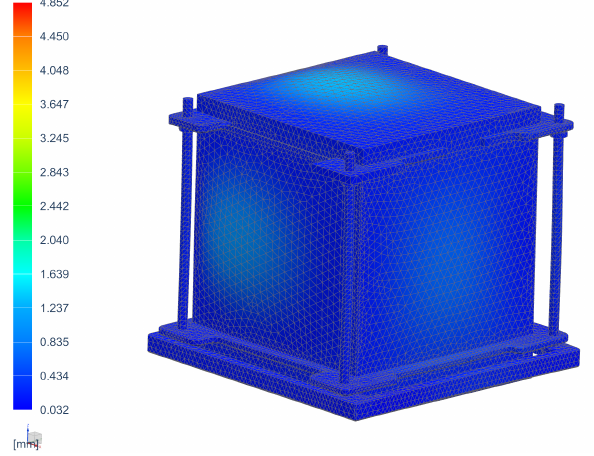
Figure 18. The payload modal analysis. This simulation meshing is based on 3D CTETRA 10 mesh, with maximum mesh size of 5mm and minimum of 1 mm. Courtesy of Basel AlTawil.